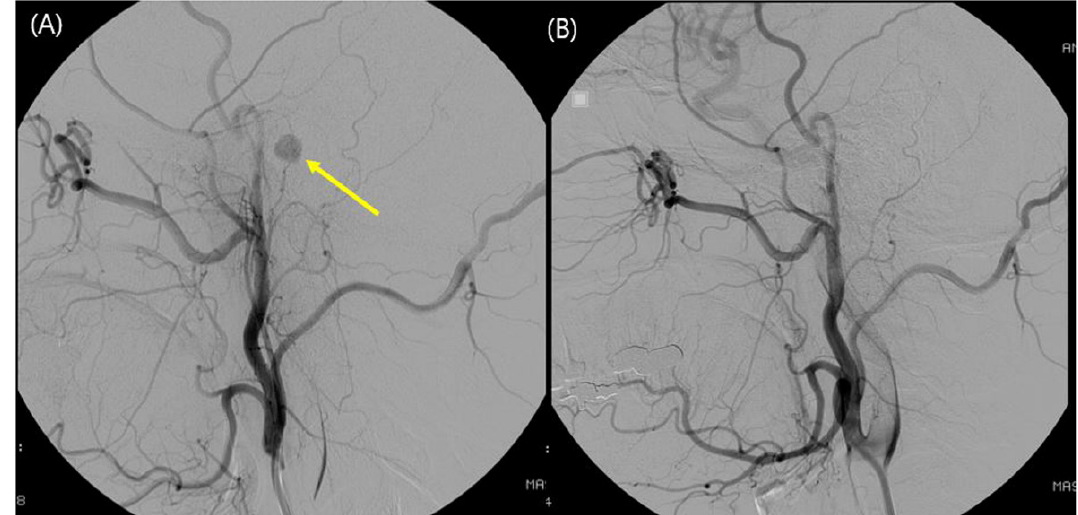
Figure 2. Preoperative transfemoral cerebral angiography (TFCA) and embolization in subject 7. ( A ) A highly vascular 6 mm-sized oval nodular lesion (yellow arrow) fed by the inferior tympanic artery from the ascending pharyngeal artery was observed during TFCA; it was suggestive of a glomus tympanicum tumor. ( B ) After superselective angiography and confirmation of the absence of any dangerous anastomosis, the feeding vessel was embolized without any complications, and the mass became invisible.